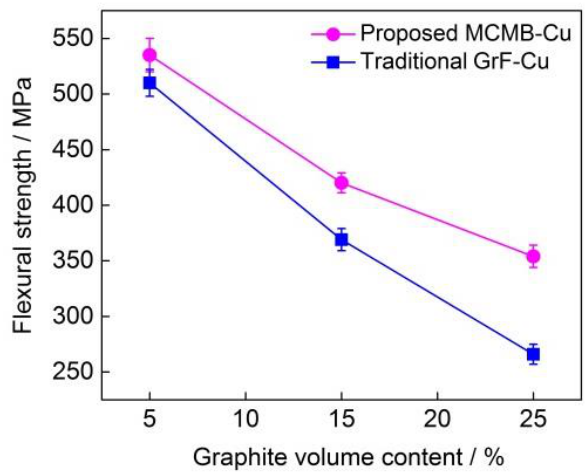
Figure 7. Flexural strengths of the MCMB–Cu and GrF–Cu composites under different MCMB and GrF volume contents.